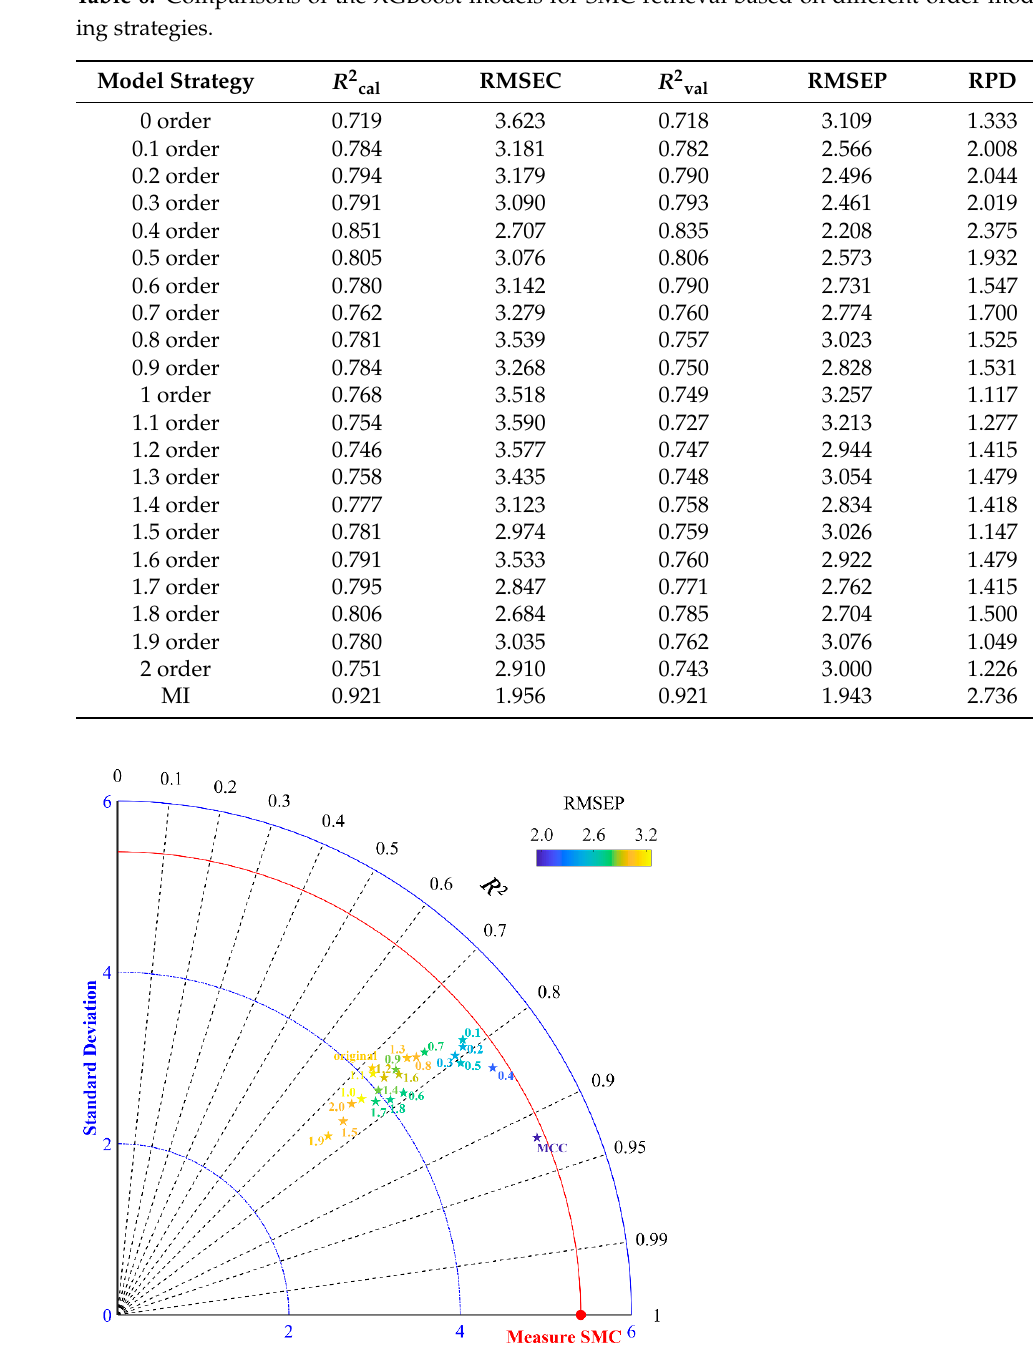
Figure 8. Taylor diagram of the estimated accuracy of each model. The black dotted line indicates R 2 val , the blue line indicates the SD, and the colored stars represent the 22 models, whose colors from dark blue to deep red indicate small to large RMSEP values. The red line represents the measured SMC.